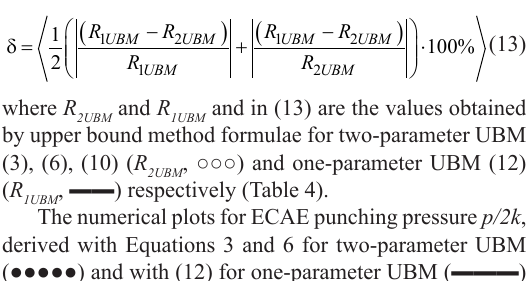
Figure 8. Computational dependencies of ECAE punching pressure p/2k (a, c) and the total plastic shear γ factor m for the ECAE Segal 2θ -dies with 2θ=75° (a, b) and 2θ=105° (c, d), derived by two-parameter UBM (○○○), and one-parameter UBM